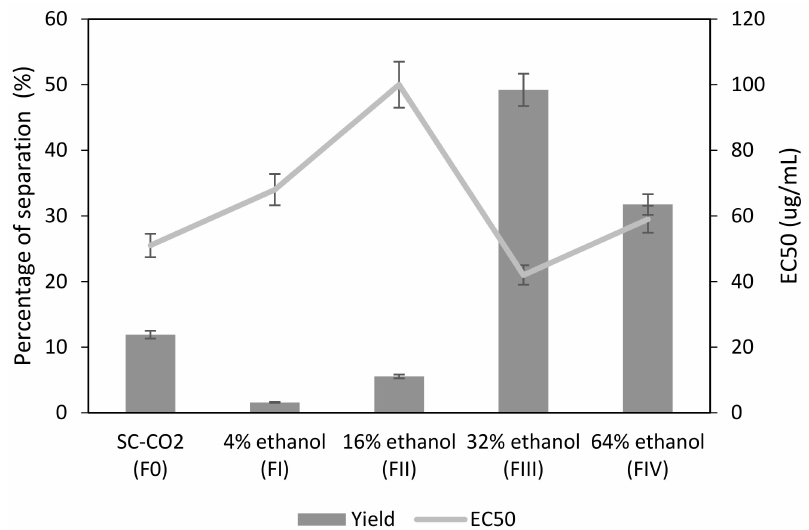
Figure 4. Yields and antioxidant activity of the extracts obtained by sequential